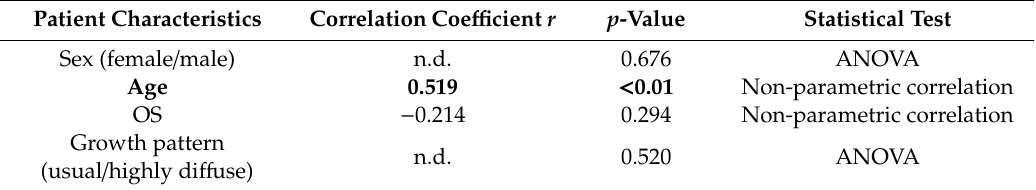
Table 3. Correlation of IDHmut glioma patients’ characteristics with RPS27 mRNA expression.